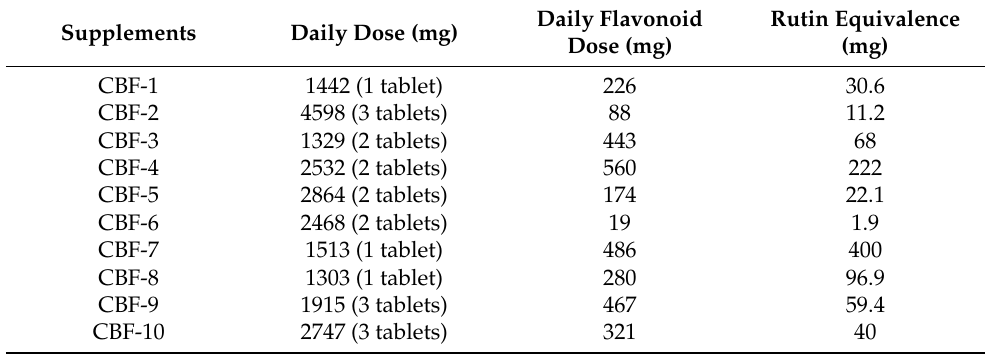
Table 4. Recommended daily dose of each supplement expressed as rutin equivalence with respect to DPP-4